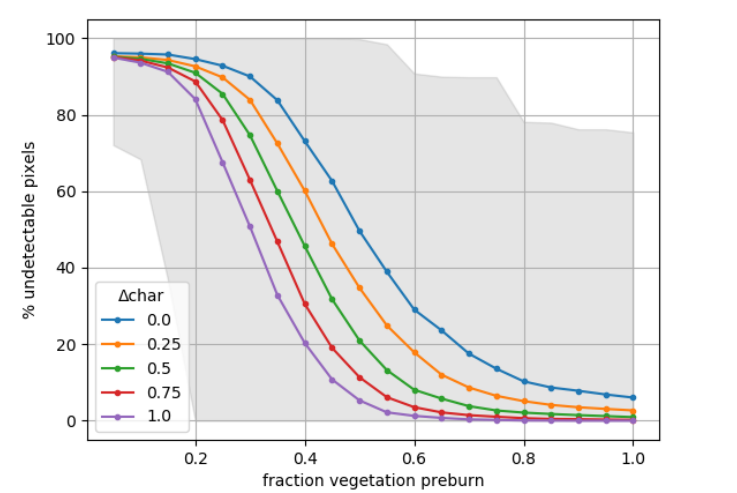
Figure 7. Percentage of undetectable pixels as a function of starting vegetation fraction and ∆ char parameter setting, park-wide for Landsat 8, dNBR threshold = 0.15. Mean values are shown in colored lines, with total model result variation shown in